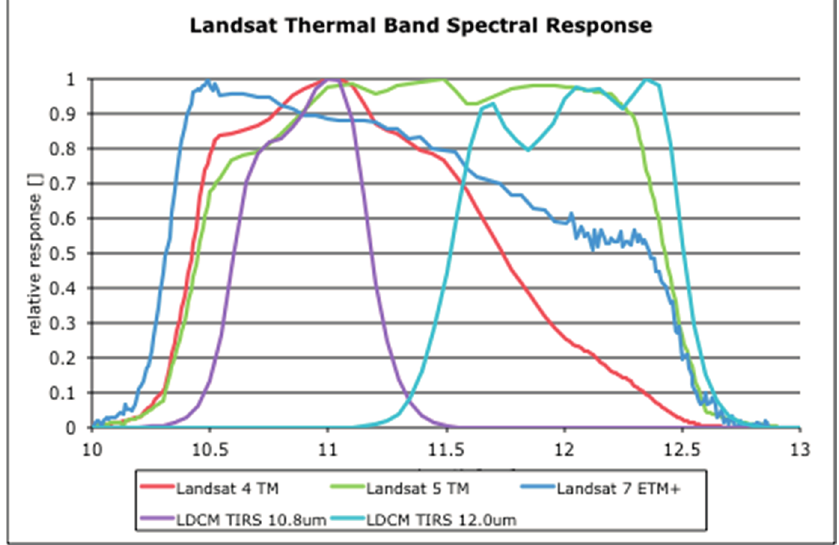
Figure 1. Comparison of the relative spectral response of the Landsat 8/LDCM TIRS thermal channels with those of previous Landsat instruments. The TIRS channels span the same spectral region as the previous